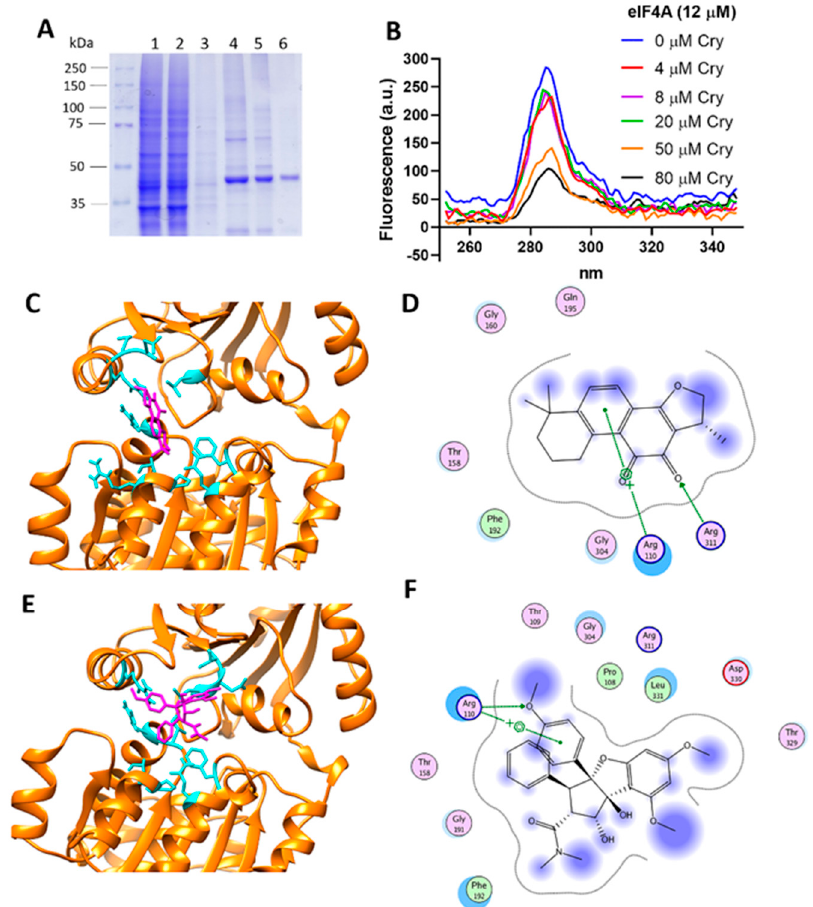
Figure 8. Cryptotanshinone (Cry) binds to translation initiation factor eIF4A1. ( A ) SDS-PAGE electrophoresis of eIF4A1 purification showing the affinity chromatography results. Lane 1: overexpression of eIF4A1; lane 2, flow-through fraction; lane 3 washing buffer with an imidazole 20 mM, lane 4 purified protein, Lane 5 and 6: His-tag cleavage with PPS after 16 h incubation. Protein of lane 6 was used in the experiments. ( B ) Binding experimentation evaluated by a synchronic mode fluorescence. A scan from 250 to 350 nm at 25 °C is showed, under eIF4A1 (12 µM) and Cry (0–80 µM) incubation. ( C ) Representative snapshot corresponding to the crystallographic structure of the eIF4A1 ⋅ ATP PDB ID: 5ZC9 (yellow) under the Cry (magenta) interaction, obtained by molecular docking. Interaction showed a − 8.19 S value. ( D ) Residues that define the eIF4A/Cry interactions. ( E ) As a control, a representative snapshot of the eIF4A1 ⋅ ATP (yellow) under the RocA (magenta) interaction. Interaction showed a − 10.04 S value. ( F ) Residues that define the eIF4A/RocA interactions.